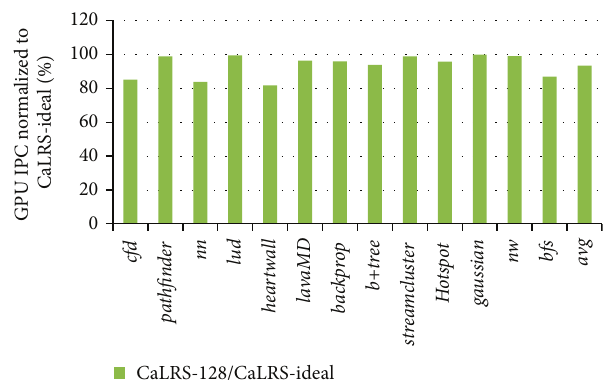
Figure 12: Performance comparison of CaLRS-128 and CaLRS-